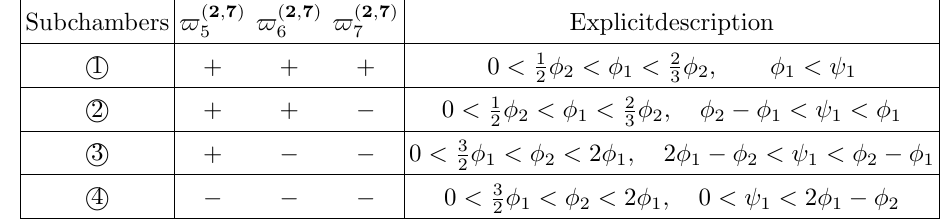
(cid:8) G R ) with R = ( 2 ; 7 ). The wall 1 2 ; . 8 (cid:0) i